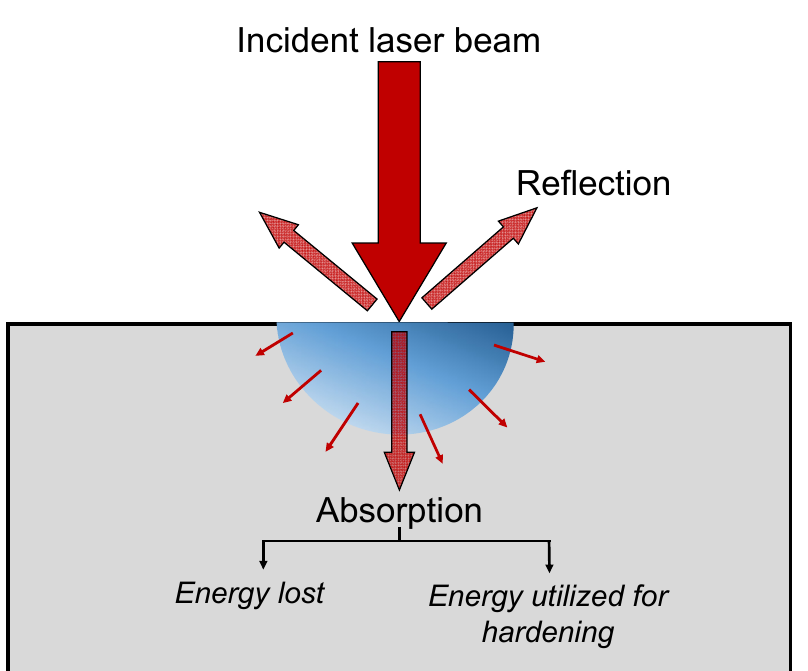
Figure 1. Schematic diagram showing laser energy transfer during laser surface hardening. It is worth pointing out that not all of the region affected by the laser heating trans- forms into martensite. Only the area near the surface where the austenitization temperature is reached or exceeded transforms into hard martensite. The martensitic